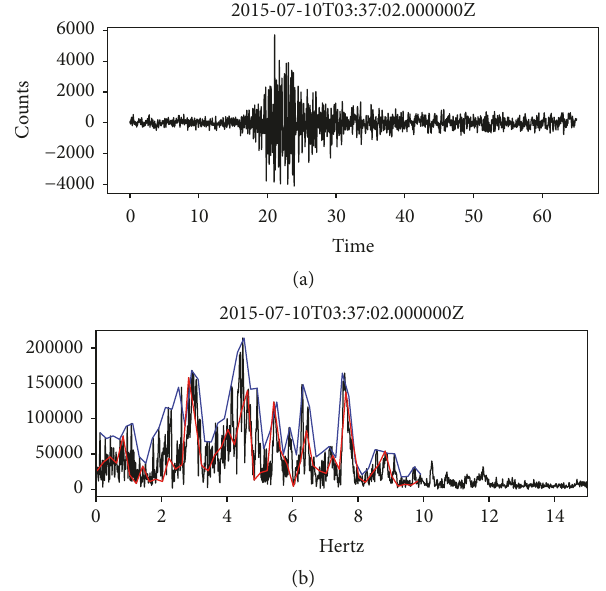
Figure 2: (a) Sample of low frequency seismic signal; (b) power spectra. The components of the feature vector are the peaks of both the blue line (maximum spectral values in 0.2Hz intervals) and red line (exact spectral value sampled in 0.2Hz